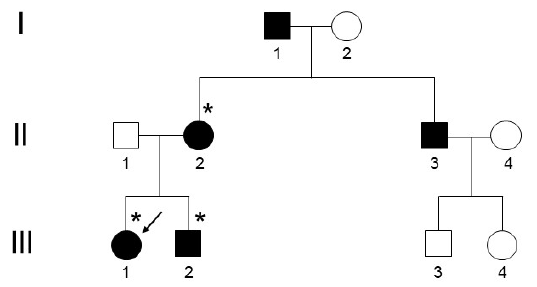
Figure 1. Pedigree of the Calabrian kindred with adFNDI. Individuals marked with an asterisk (*) agreed to genetic testing. The arrow indicates the index patient who was clinically and radiologi- cally assessed.